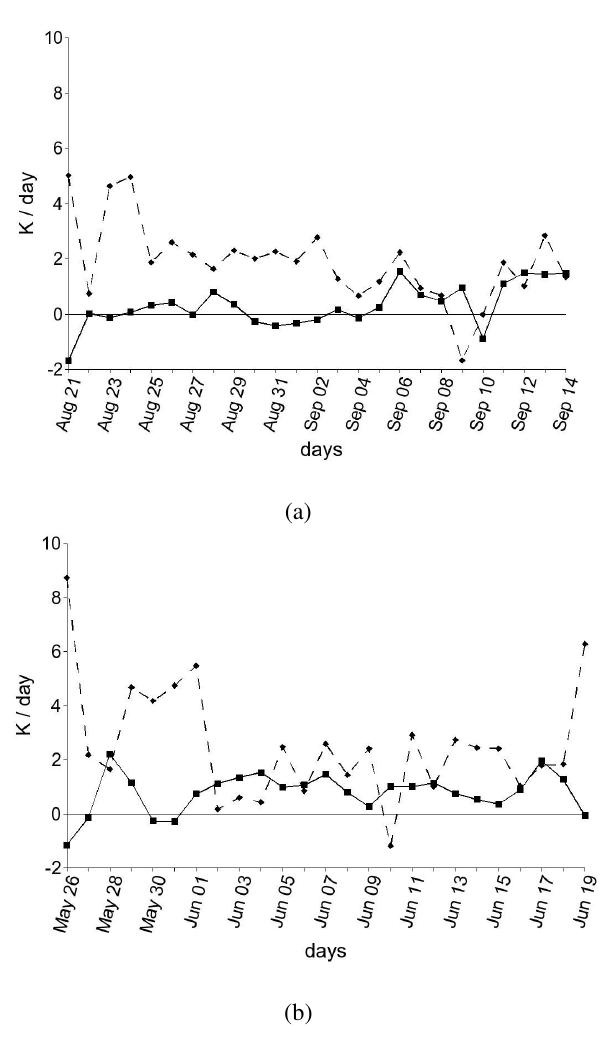
Fig 14 – Evolution of target-area average horizontal thermal advection (full lines) and adiabatic heating (broken lines) (K day -1 ) at 700-hPa for (a) Case 29 and (b) Case 32. Fig. 14. Evolution of target-area average horizontal thermal advec- tion (full lines) and adiabatic heating (broken lines) (K day − 1 ) at 700-hPa for (a) Case 29 and (b) Case